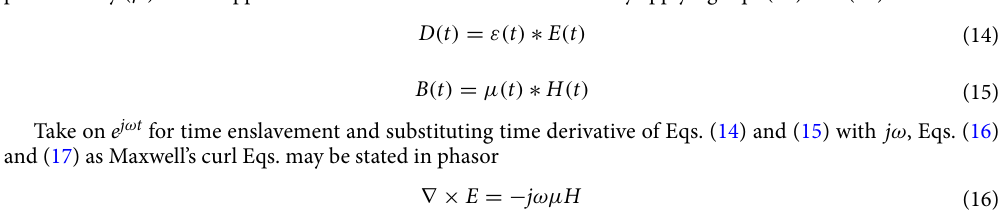
absorption resonances are shown in Fig. 10. At the resonance frequency 3.80 GHz, current flows via the lower and upper left side of two outer rings and the lower right side of the outermost ring. The left segment of the inside ring provides significantly to flow a sufficient quantity of current. The other parts of split rings of horizontal current flows are very small, as depicted in Fig. 10a. The current components of this portion are anti. In the backside, the evenly distributed moderate current flows, which is anti-parallel to the front-end current parallel presented in Fig. 10f. This front and back layer anti-parallel current initiates a current loop, which produces magnetic dipole resonance 41 . At 5.65 GHz, current flows via the left top outermost square split ring and middle ring, as shown